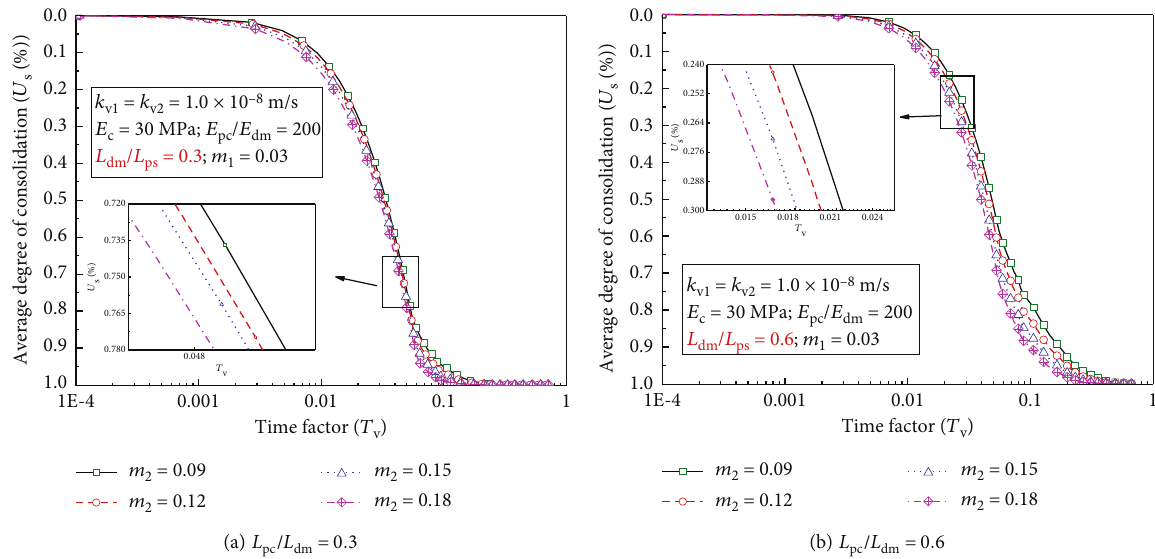
Figure 8: E ff ect of m